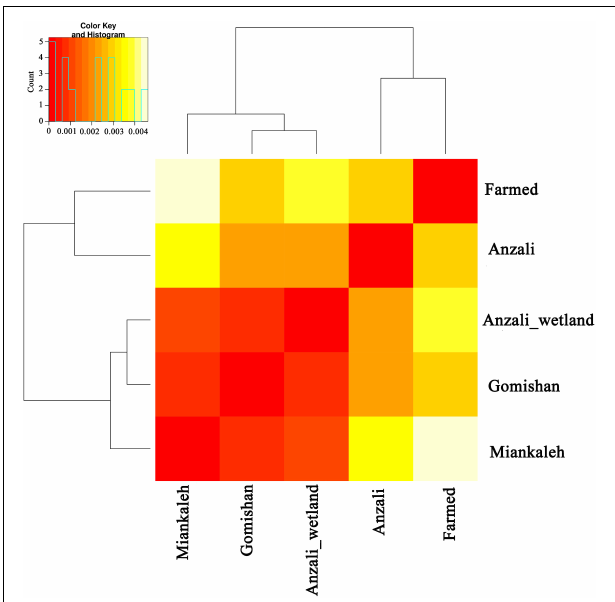
FIGURE 3 | Pairwise genetic distances between C. carpio populations and clustering based on 17,828 SNP markers.